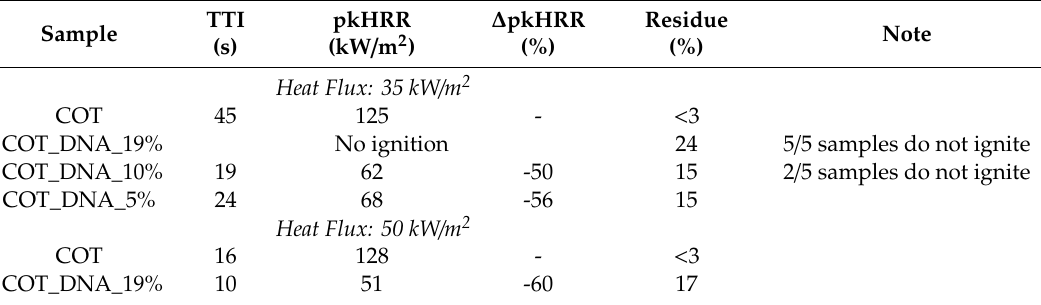
Table 10. Cone calorimetry data of untreated and DNA-treated cotton